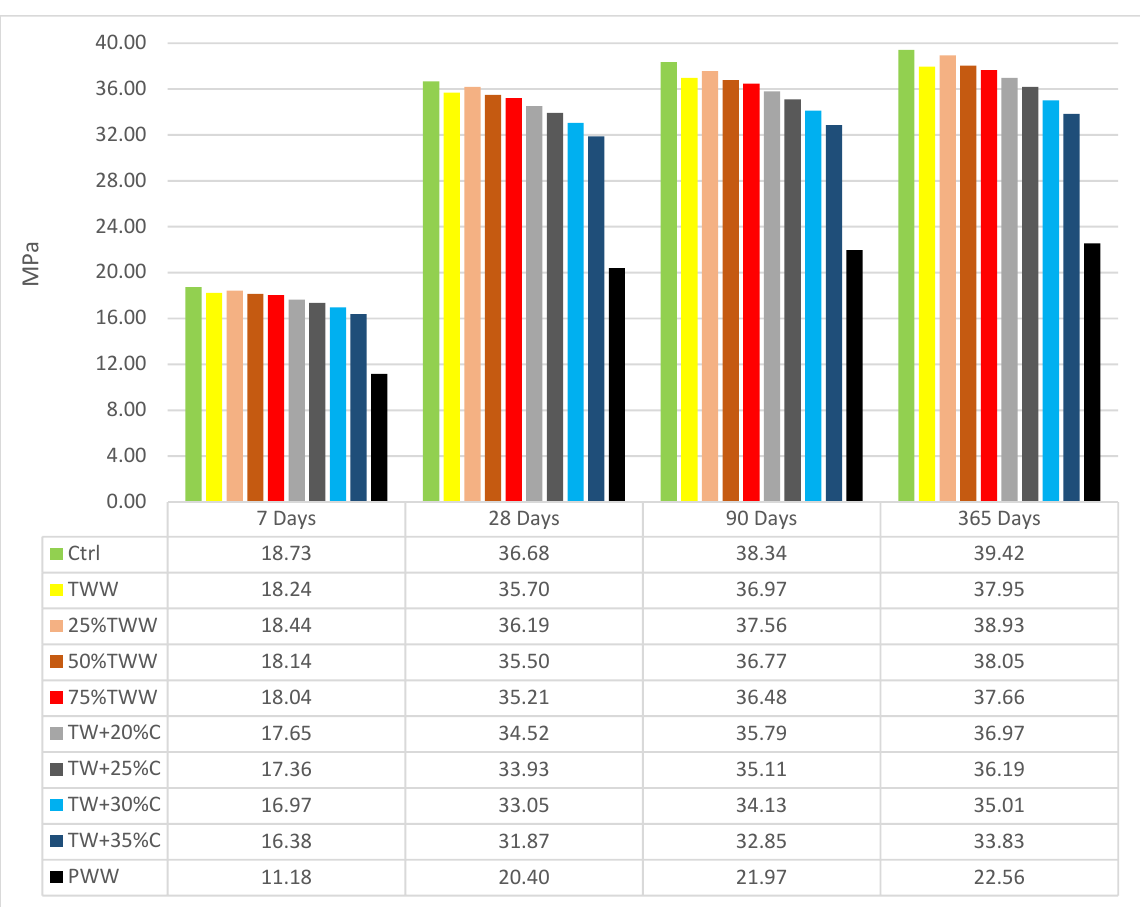
mix design [36]. The chemical and physical characteristics of TW + 30%C were as follows: BOD: 150 mg/L, COD: 200 mg/L; Total Dissolved Solid: 1924 mg/L; Total